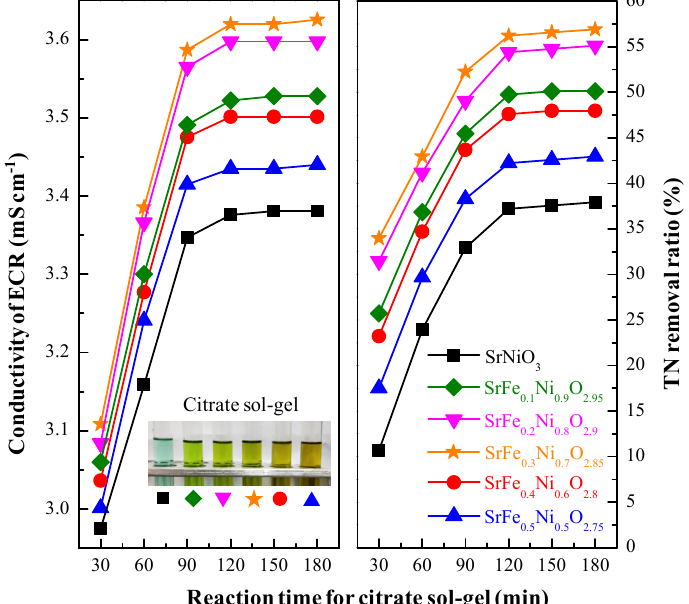
Figure 4. The effect of reaction time for citrate sol-gel on the electrocatalytic properties of SrFe x Ni 1− x O